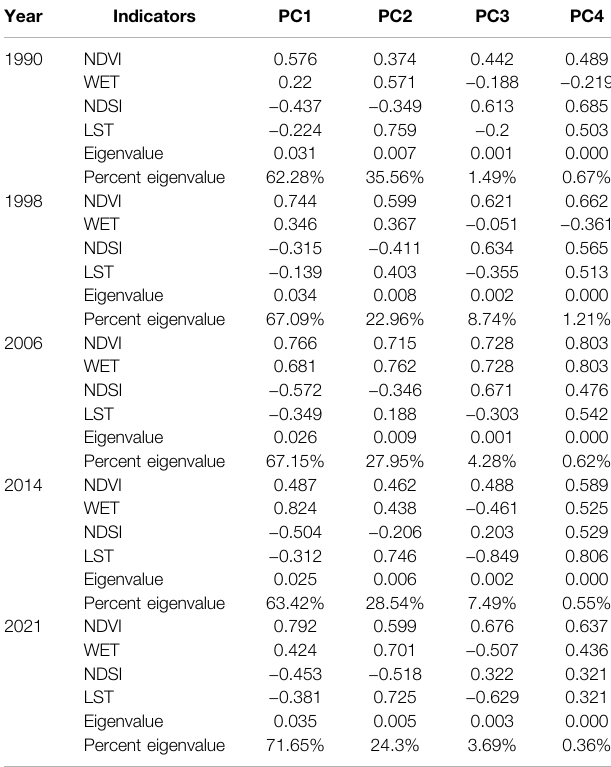
TABLE 3 | Principal component analysis results of the RSEI from 1990 to